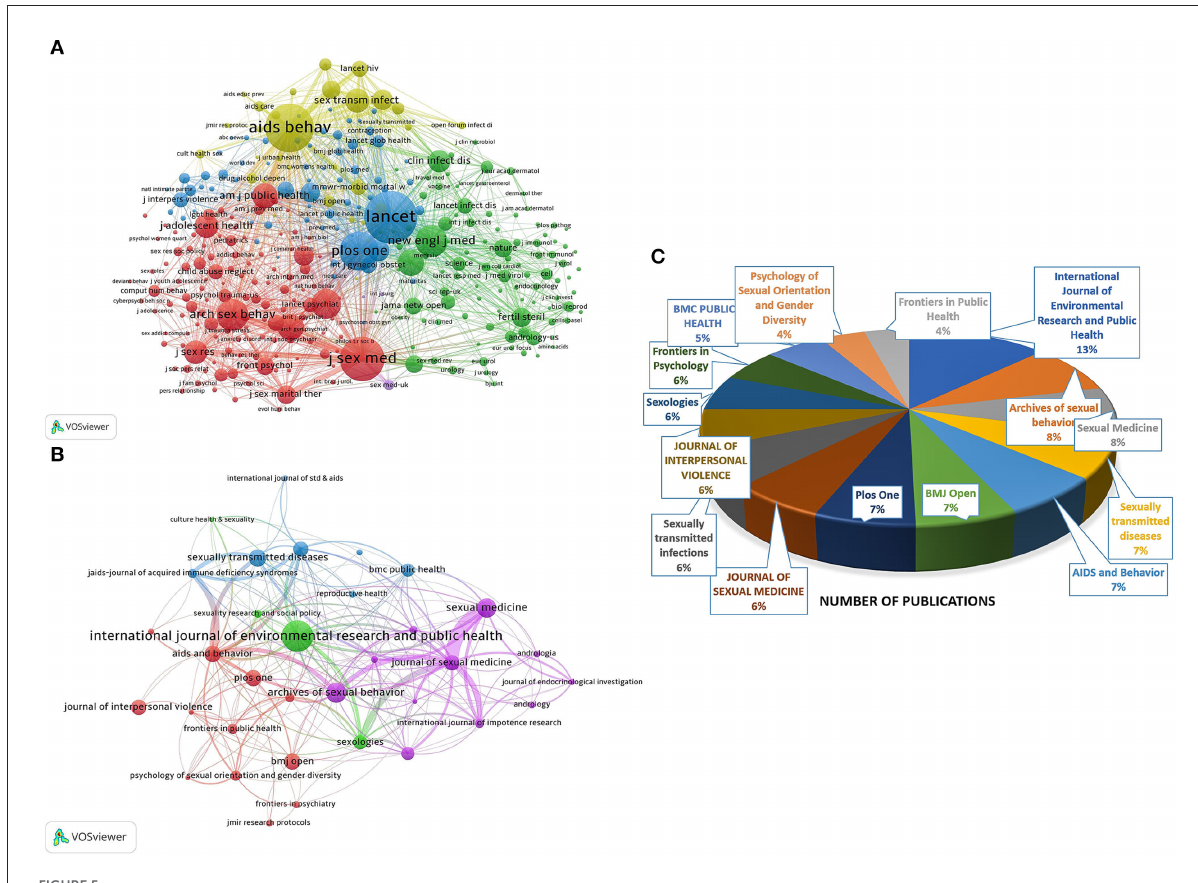
FIGURE5 Visualization map of journals. (A) Co-citation network of journals based on reference sources. (B) Cross-citation analysis of journals. (C) Pie chart of top 15 journals that published the largest number of documents.